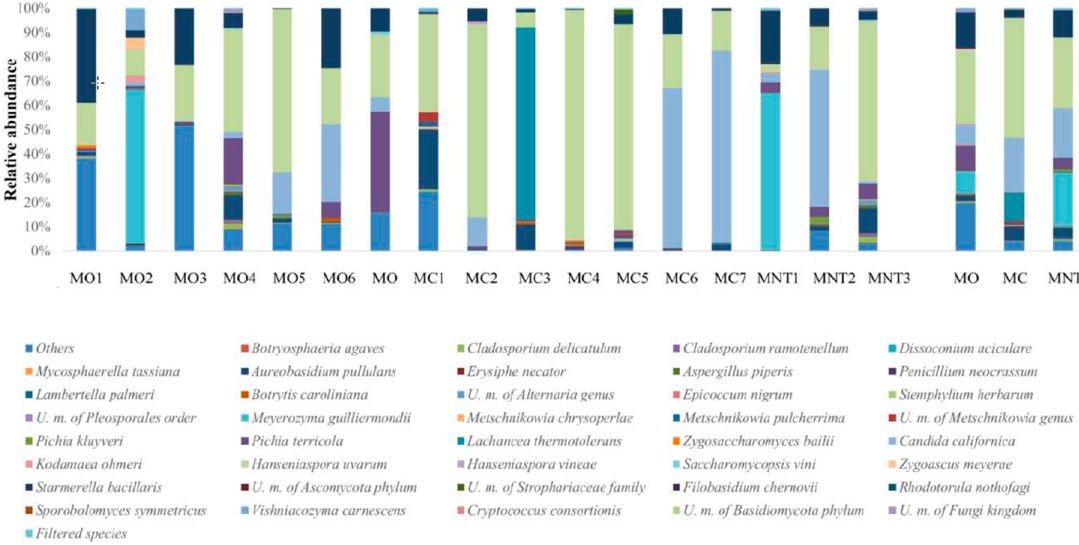
Figure 6. Relative abundance of fungal community detected by NGS at the 15 th day of spontaneous fermentation in organic (MO), conventional (MC) and not treated (MNT) samples. The number associated to the samples represents the replicates for each treatment. In the microorganism legend, U.m. abbreviation means undefined microorganism. Only the taxa > 0.5% are shown and the taxa ≤ 0.5% were grouped under the heading Filtered species of the legend. To the right of the graph, mean values of each treatment are represented (MO, MC and MNT).